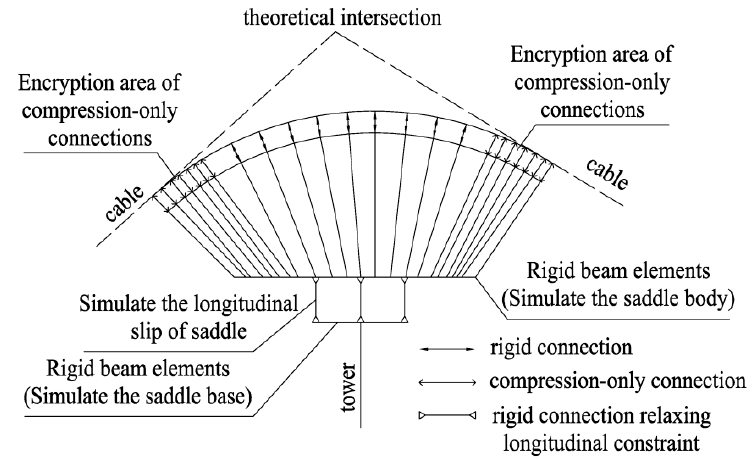
Figure 6. Finite element simulation of the saddle.